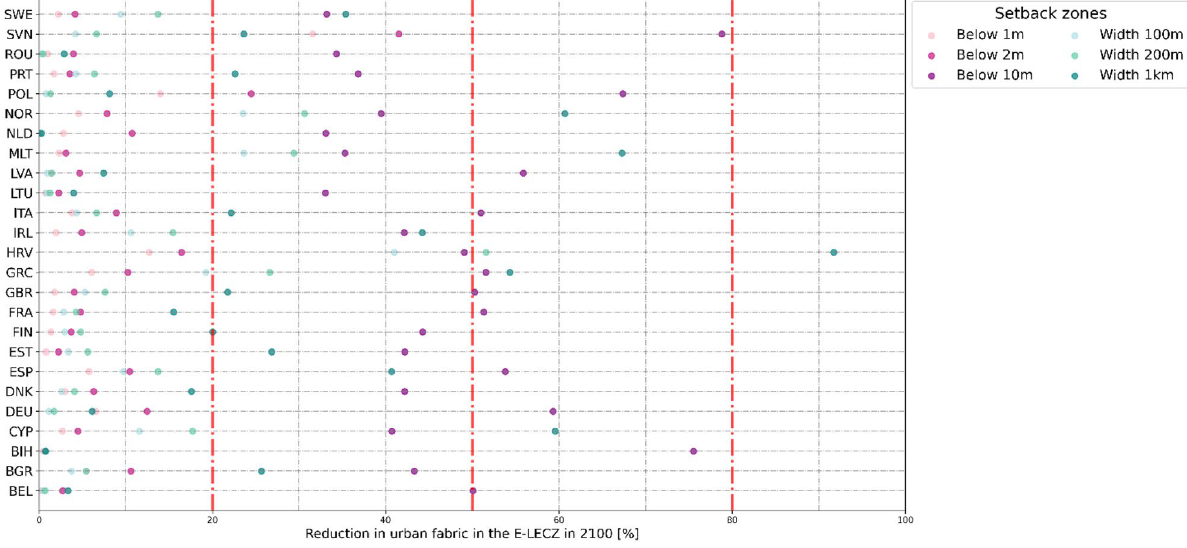
Figure 7. Reduction in exposure of new urban fabric in the E-LECZ under different setback zones until 2100 [high urban growth